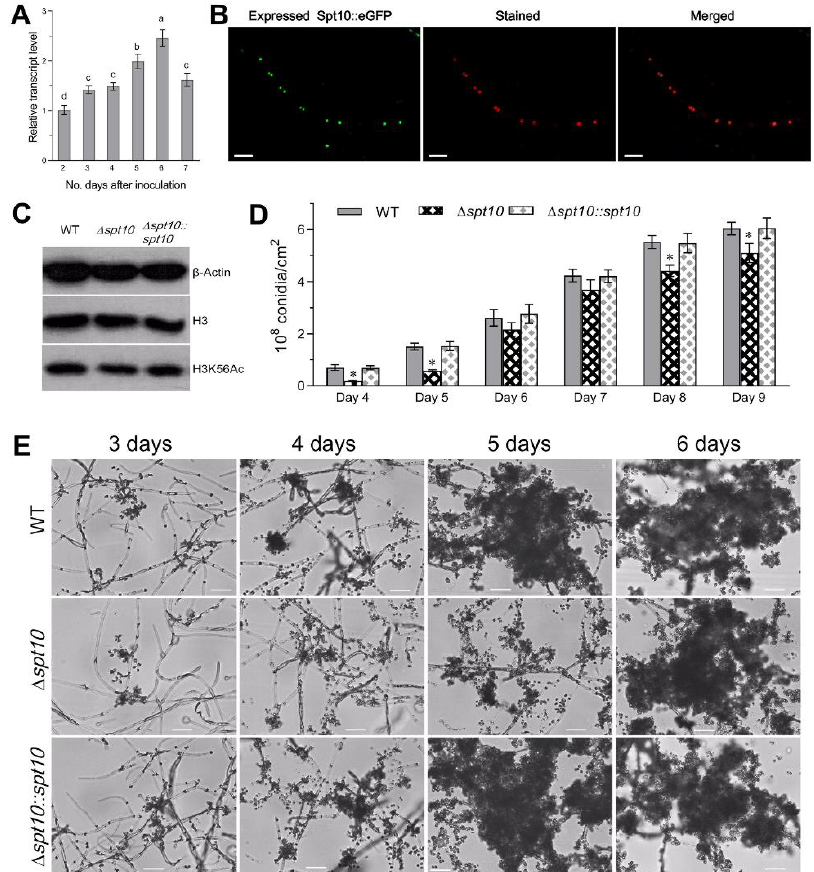
Figure 1. Transcriptional expression, subcelular localization of Spt10 in B. bassiana . ( A ) Relative transcript levels of Spt10 in the WT cultures during 7-day incubation on SDAY at 25 °C with respect to the standard on day 2. Error bars: SD from three cDNA samples. ( B ) LSCM images (scale bars: 10 µm) for subcellular localization of GFP tagged Spt10 fusion protein expressed in WT. Hyphal cells were collected from 3-day-old SDB culture and stained with the nuclear dye Hoechst 33258. ( C ) Western blots for acetylation levels of histones H3-K56 in the protein extracts isolated from 3-day-old SDB cultures. ( D , E ) Conidial yields quantified or conidiation images under microscopy (scale bars: 20 µm) during normal cultivation on SDAY plates, which were spread with 100 μL aliquotes of a 10 7 conidia ml –1 suspension for culture initiation. (Tukey's HSD, * indicates p < 0.05)